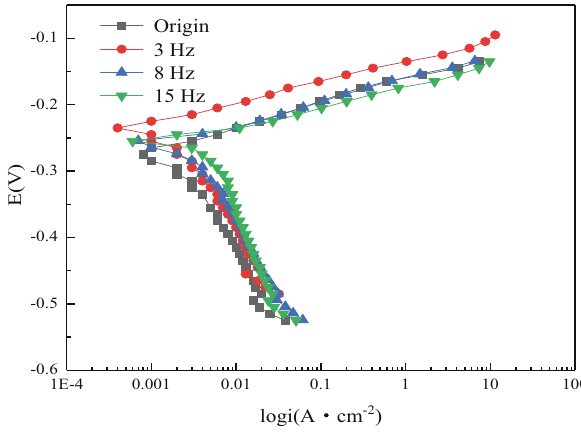
Figure 2: Polarization curves of brass alloy with and without EPT.